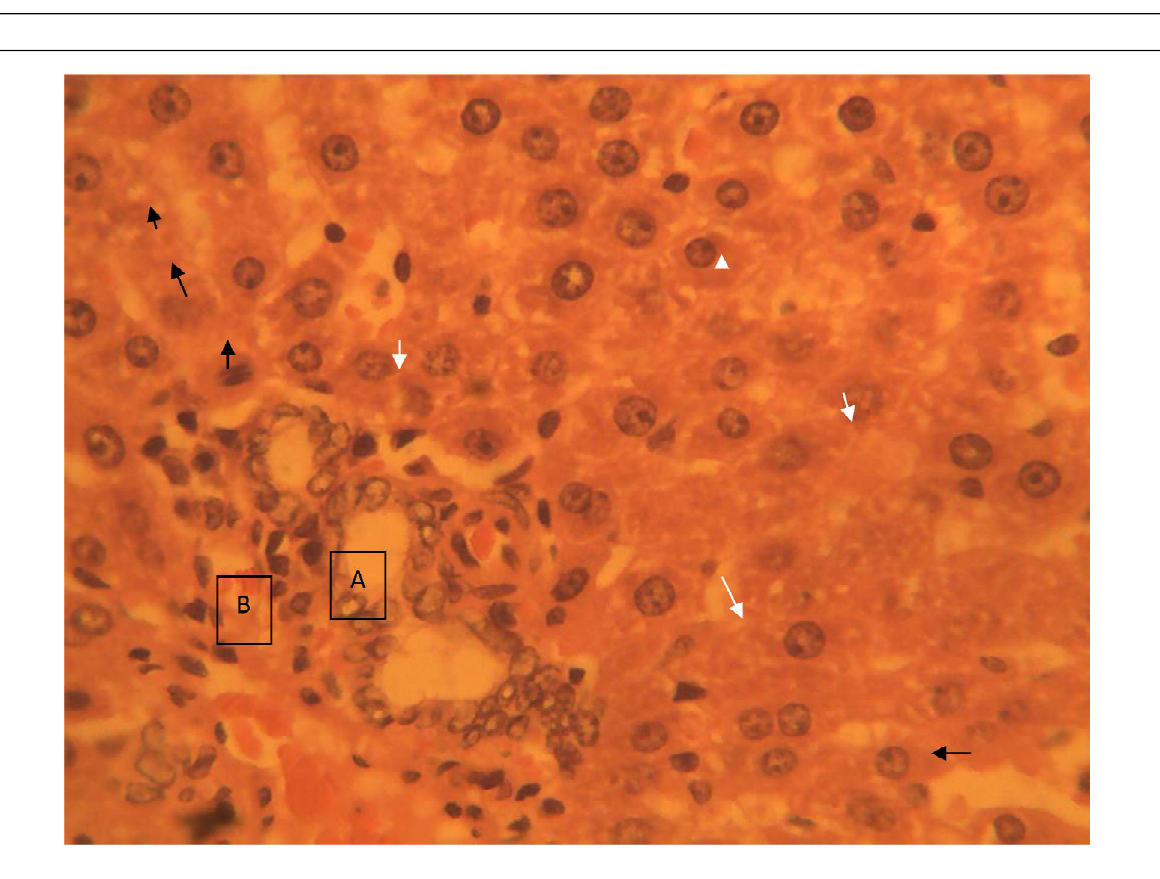
Plate 14: Female liver of the group exposed to 200 mg/kg of methanol